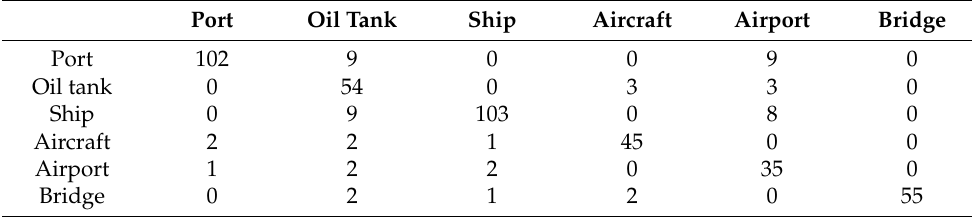
Table 4. Confusion matrix-based Verification target detection network